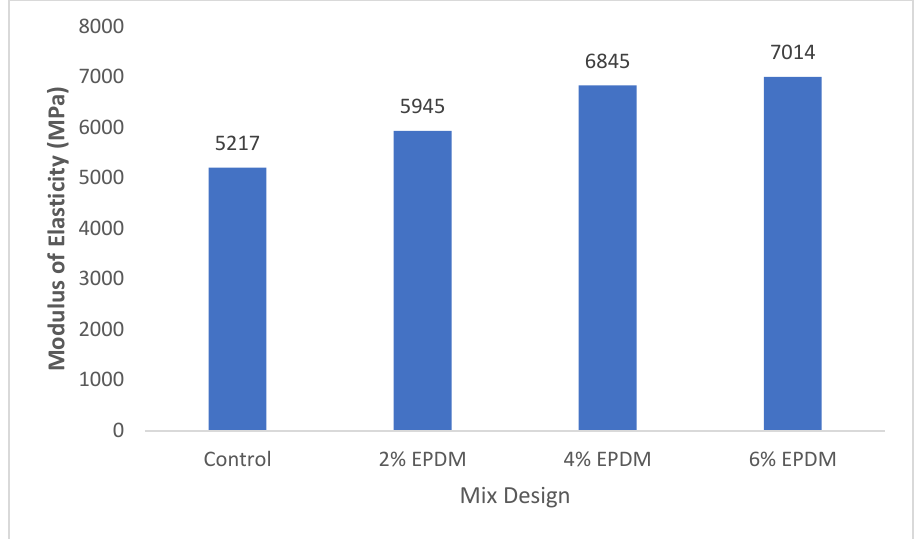
Figure 8. Modulus of elasticity results.